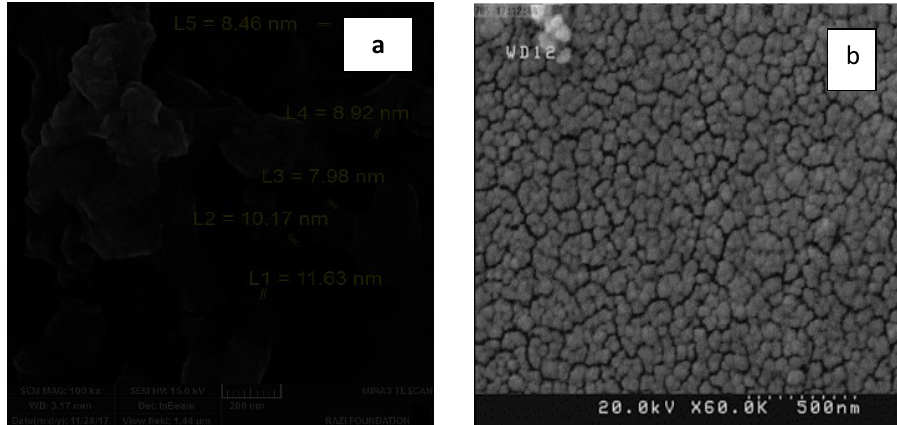
Figure 5: FESEM images of Co